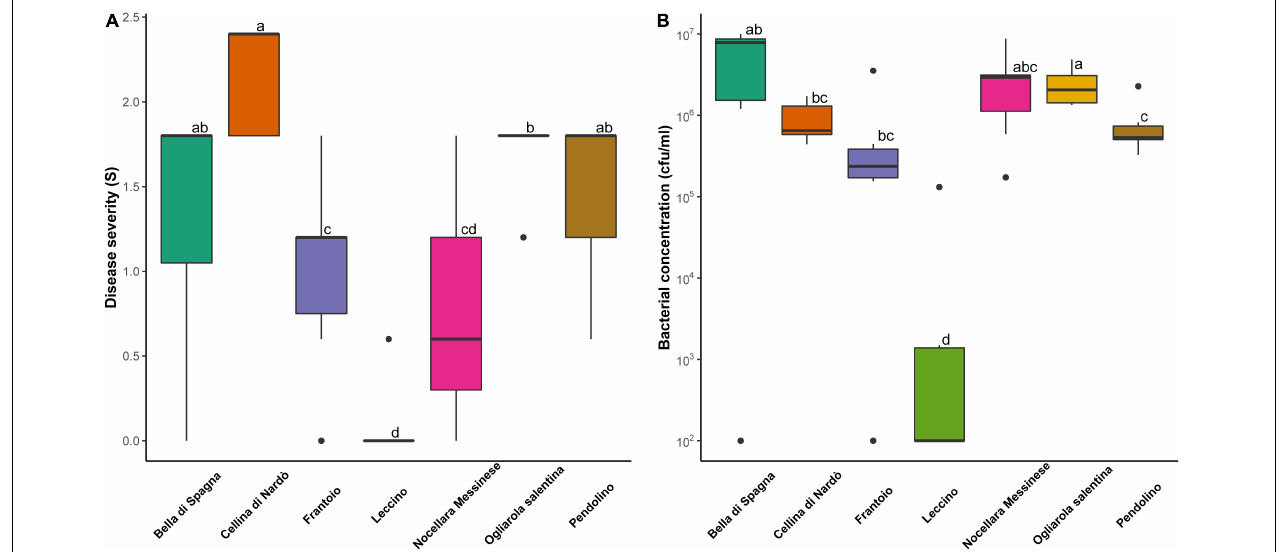
FIGURE 4 | Distribution of (A) disease severity and (B) bacterial concentration observed for eight biological replicates of the following olive cultivars: ‘Bella di Spagna’, ‘Cellina di Nardo’, ‘Frantoio’, ‘Leccino’, ‘Nocellara Messinese’, ‘Ogliarola Salentina’, and ‘Pendolino’. Different letters indicate significant differences following the application of the Wilcoxon rank-sum test ( p <